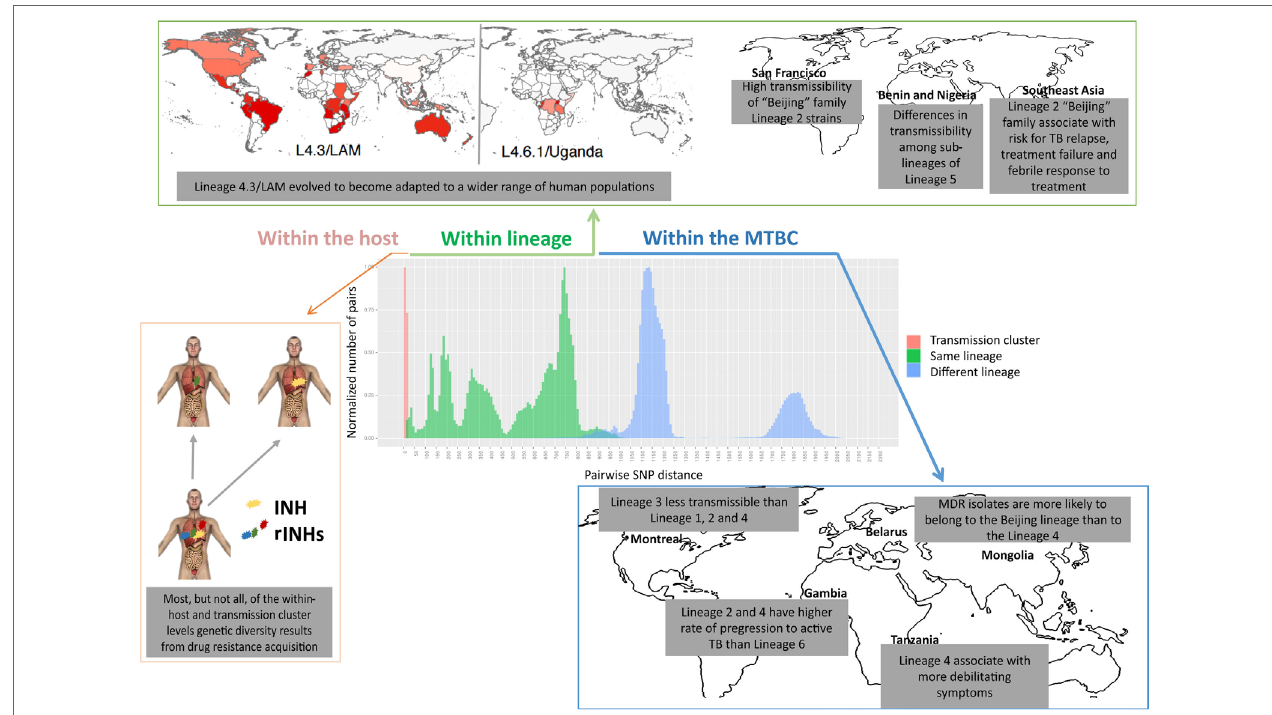
FigURe 3 | Levels of genetic diversity across the Mycobacterium tuberculosis complex (MTBC) and its epidemiological and clinical impact. There are different levels of diversity across the MTBC. Within a host or transmission chain, M. tuberculosis isolates typically differ in less than 25 single-nucleotide polymorphisms (SNPs). Diversity increases when comparing isolates within the same lineage (around 25–1,000 SNPs) or within different lineages of the MTBC (around 1,000–2,000 SNPs). This diversity impacts host/pathogen interactions, particularly the intensity and quality of the immune response and the clinical outcome, at the levels of drug acquisition, adaptation to different populations, transmissibility, or disease